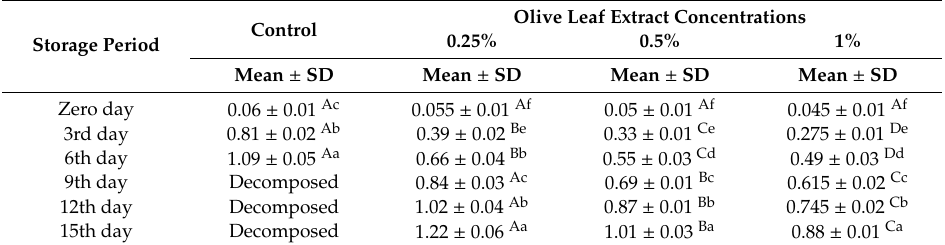
Table 4. Pattern of thiobarbituric acid (TBA) (mg / kg) of the poultry meat treated with di ff erent concentrations of olive leaf extracts during the chilling storage period at 4 ± 1 ◦ C (mean ± standard deviation